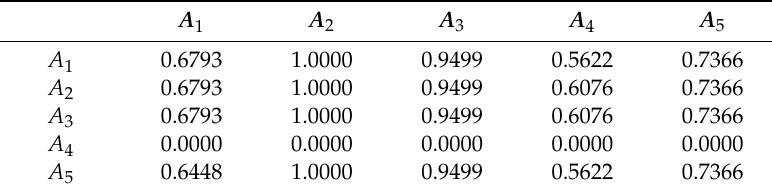
Table 13. Transformed probability of the alternative A 4 to A k .